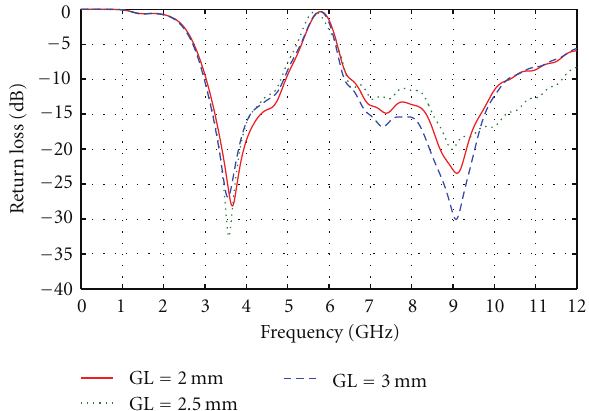
Figure 4: Simulated return losses due to parameter